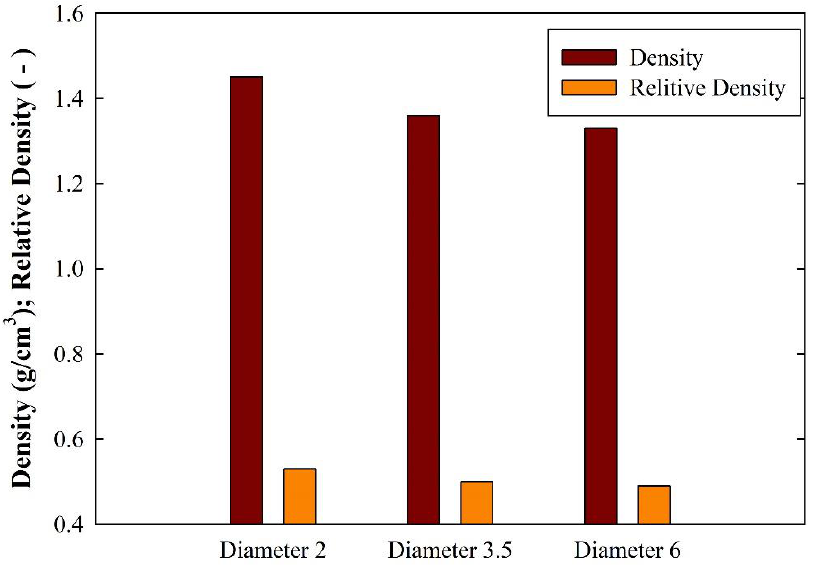
Figure 5. Produced sample densities.